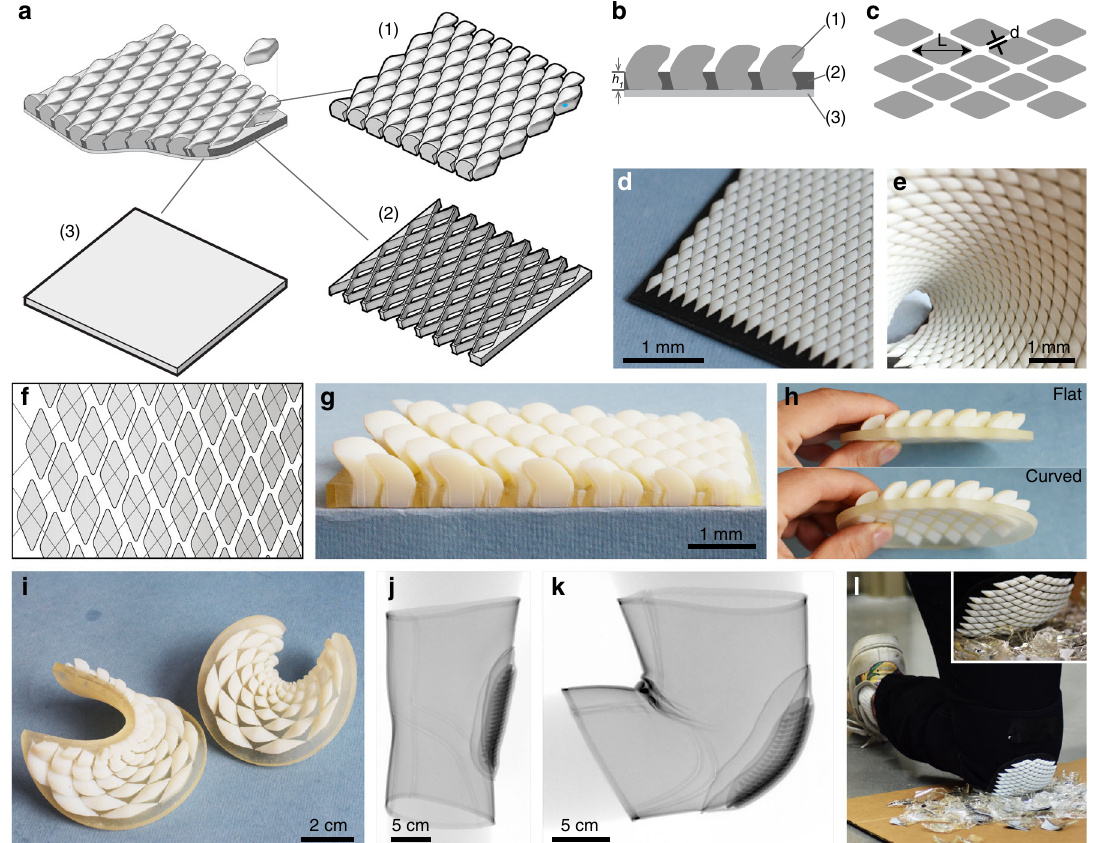
Fig. 6 Design and fabrication of a bio-inspired fl exible scaled armor. a Schematic diagram showing the basic components of the bio-inspired scaled armor, i.e., (1) scales, (2) matrix, and (3) soft underlying layer. b Side- and c bottom view of the scaled armor. d , the inter-scale spacing. d Flat panel with uniform scales fabricated through additive manufacturing. e A bent panel showing its excellent fl exibility. f , g Design of scale pattern with size gradients. h Scale assembly in fl at (top) and curved (bottom) substrate. i Scale assembly on double-curved surfaces. j X-ray projection images of a kneepad based on the bio- inspired scaled protective panel in j extended and k bent positions, demonstrating its conformability and fl exibility. l Demonstration of the protection capability of the chiton scale-inspired kneepad on broken